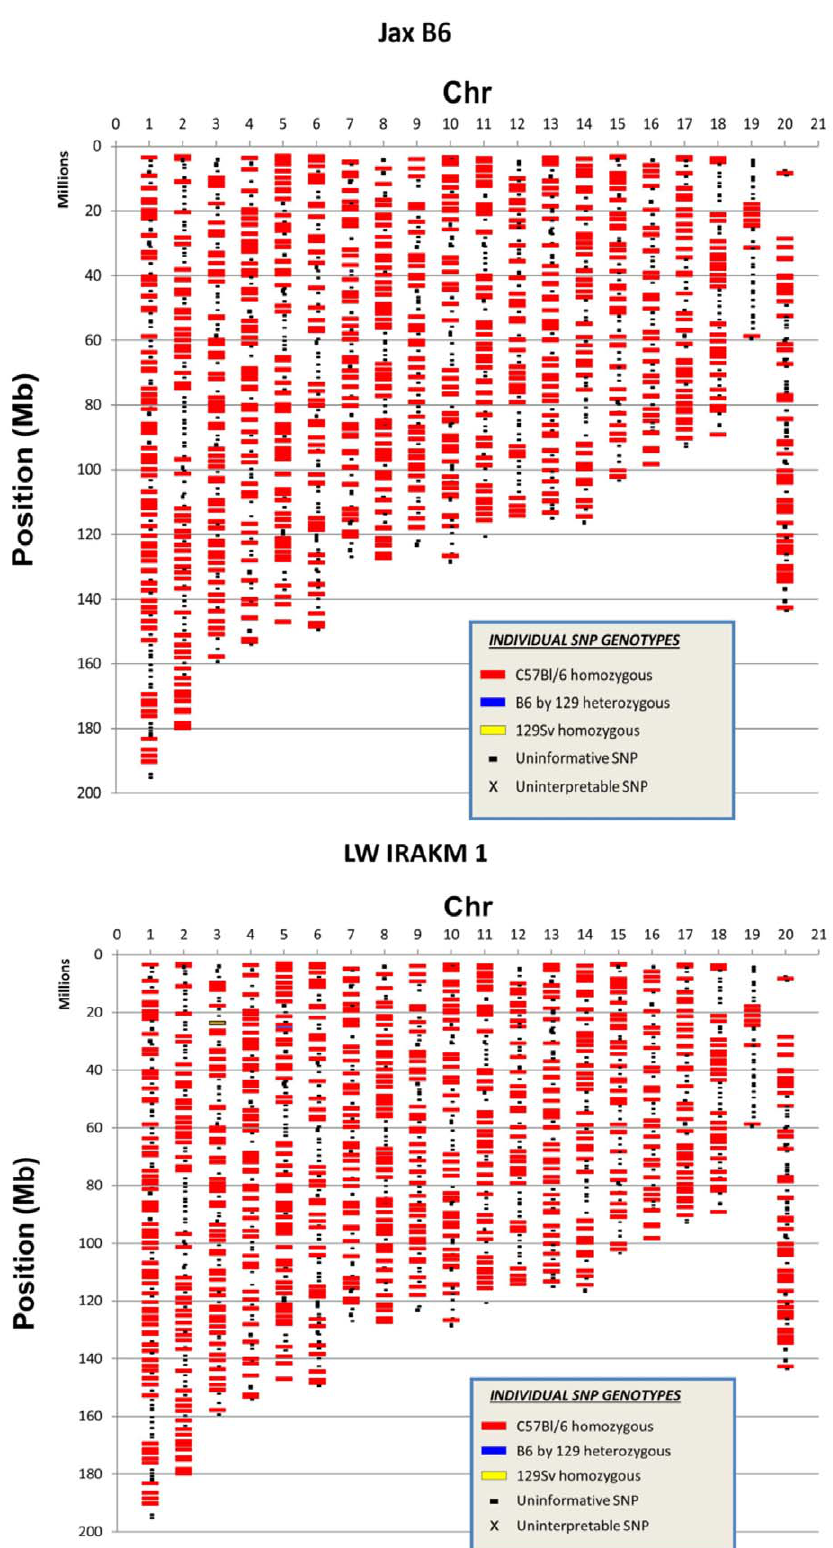
Figure 1. Genome analysis. The genetic purity of IRAK-M 2 / 2 B6 mice was analyzed with genomic DNA from IRAK-M 2 / 2 B6 mice (breeders). WT B6 mice from the Jackson Laboratory were used as controls. Genomic SNP analysis of one WT control (upper) and one IRAK-M 2 / 2 mouse (lower) is shown in the figure.